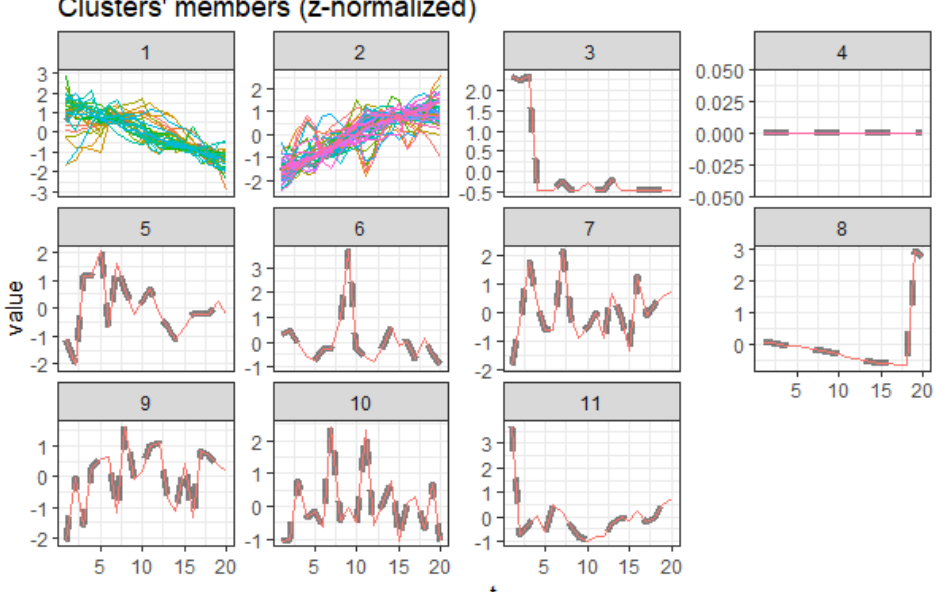
Figure 11. Cluster extraction for females aged over 60.